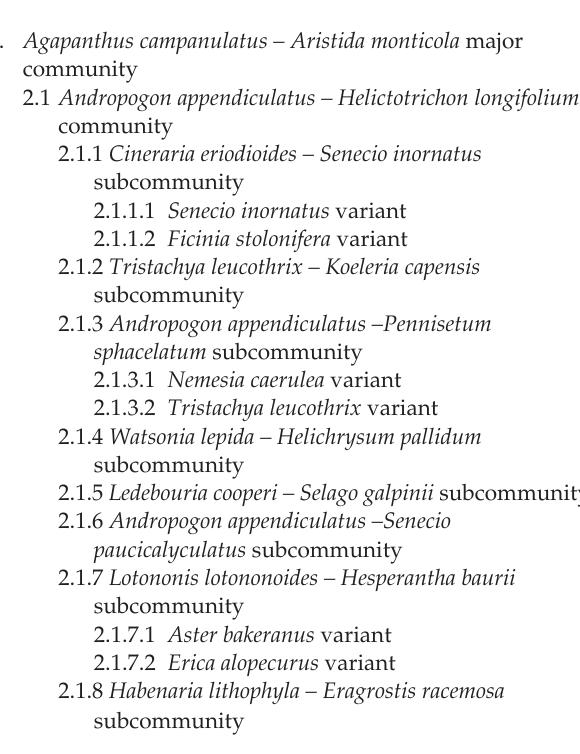
FIGURE 2: Topography of